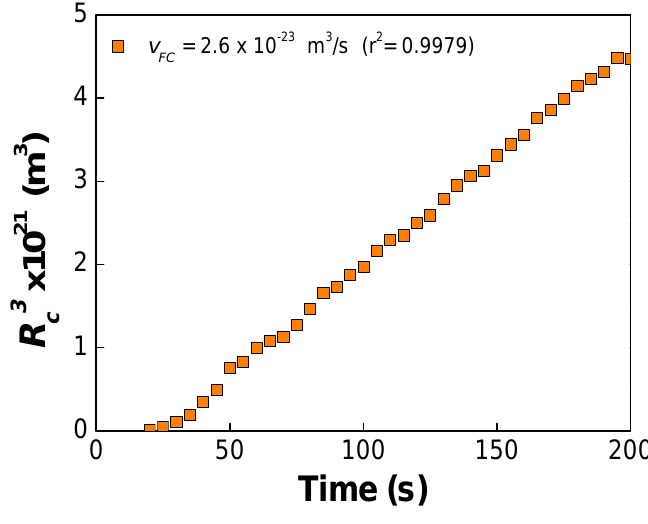
Figure 10. Experimental variation of the cube average radius as function of time. The data corresponds to a dodecane-in-water nano-emulsion produced by